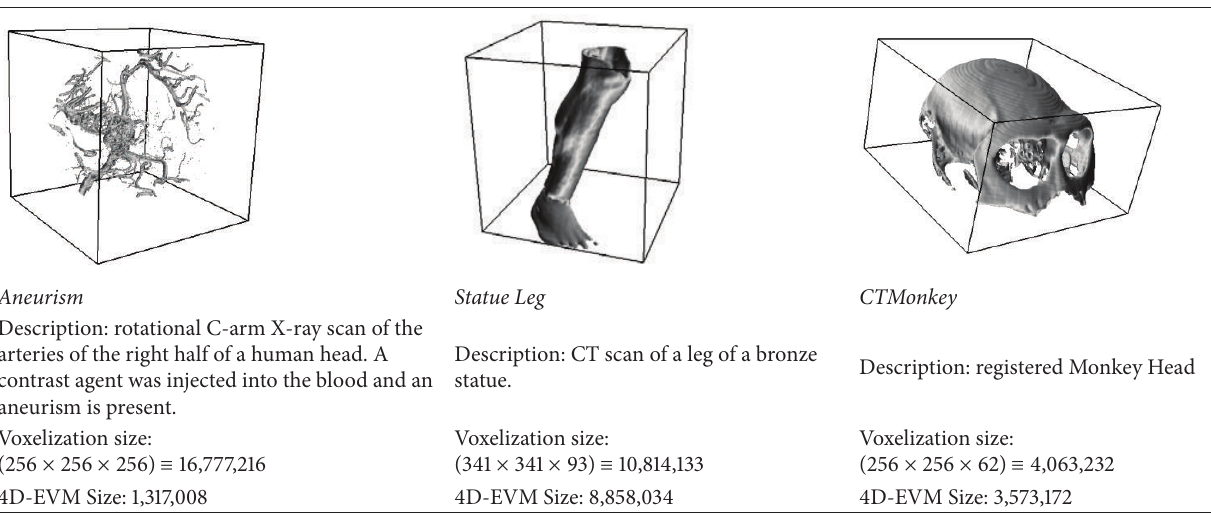
Description: CT scan of a leg of a bronze Description: registered Monkey statue.